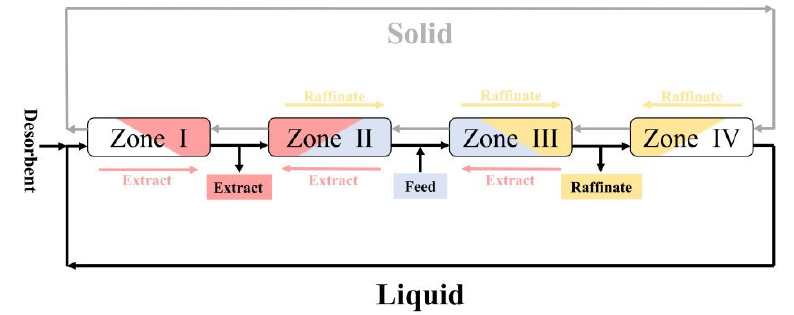
Figure 1. Schematic diagram of counter-current movement.